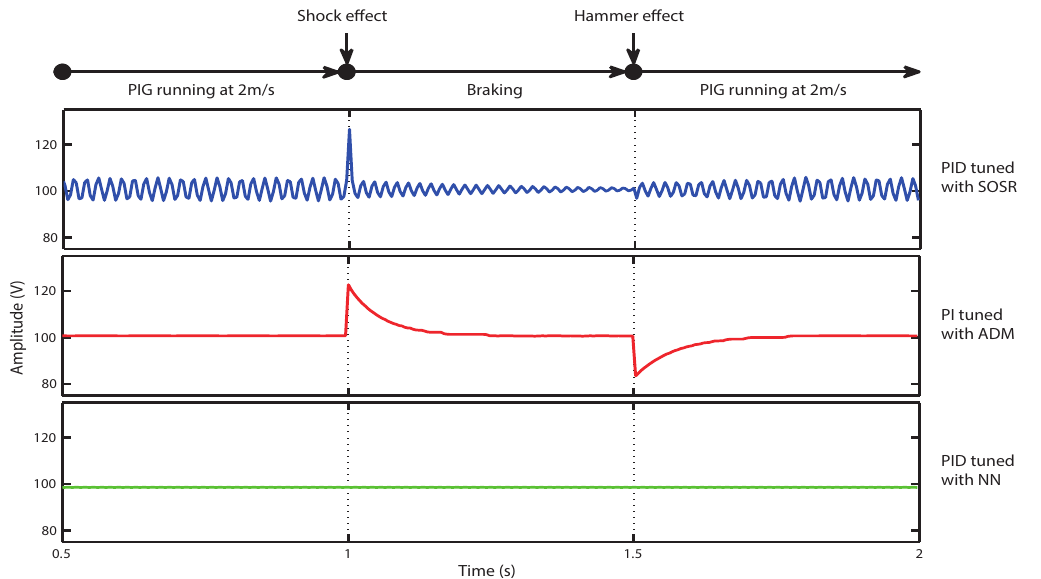
Figure 14. Shock and hammer effect responses for the control schemes.